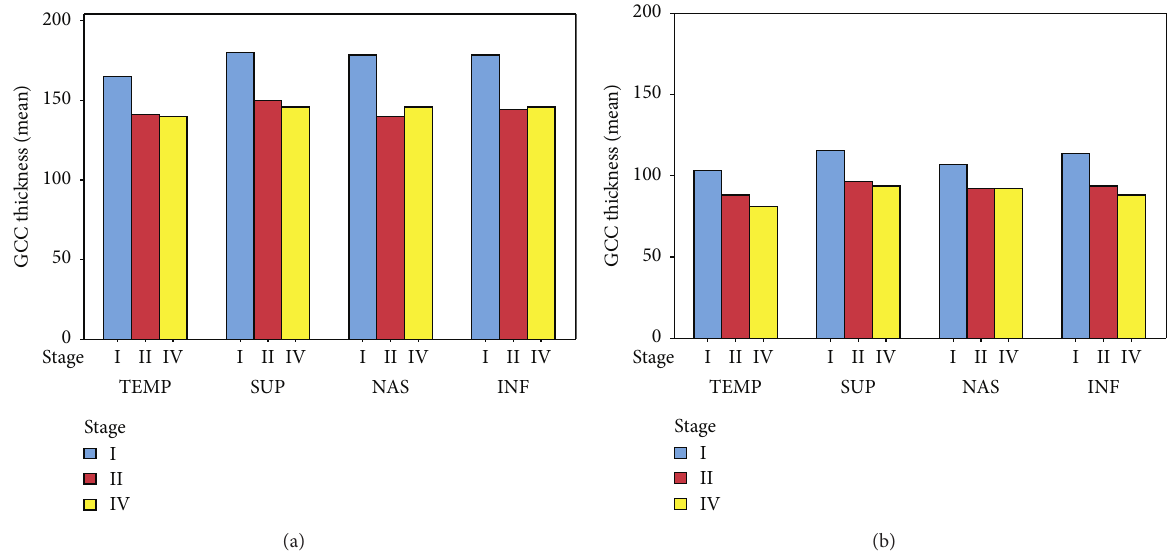
Figure 6: Mean preoperative and postoperative GCC thickness of the perifoveal quadrants of three groups: (a) preoperative GCC thickness of perifoveal quadrants and (b) 3-month GCC thickness of perifoveal quadrants.